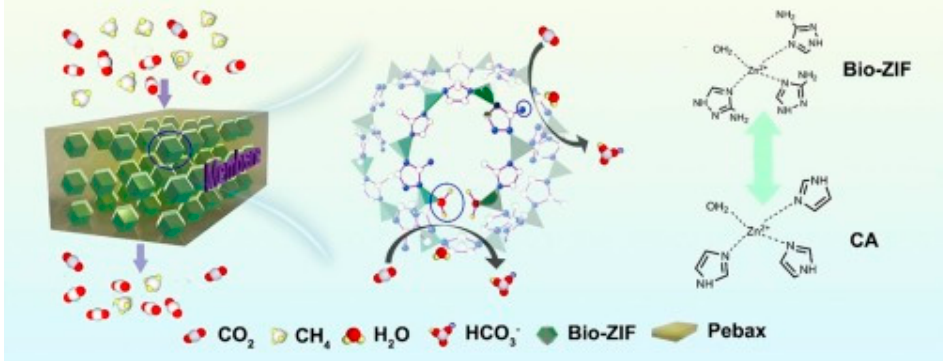
Figure 6. Scheme of MMMs incorporating a bio ‐ inspired filler for CO 2 separation (from ref. [75]).